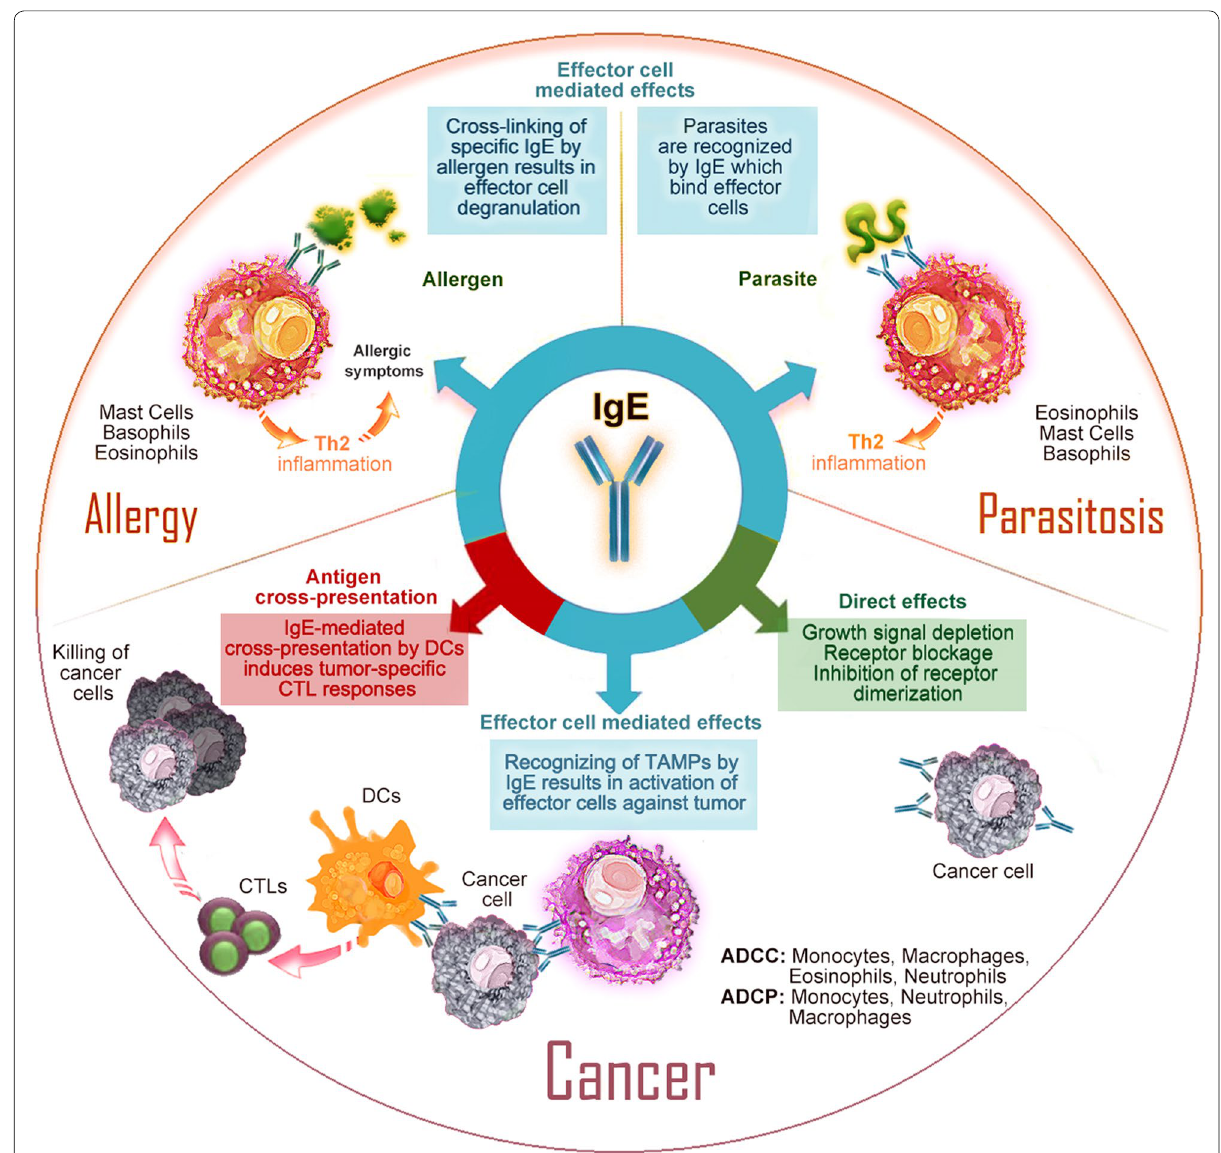
Fig. 1 The IgE isotype uniquely encompasses effector function in the pathophysiologies of allergic reactions, parasitosis, and tumour